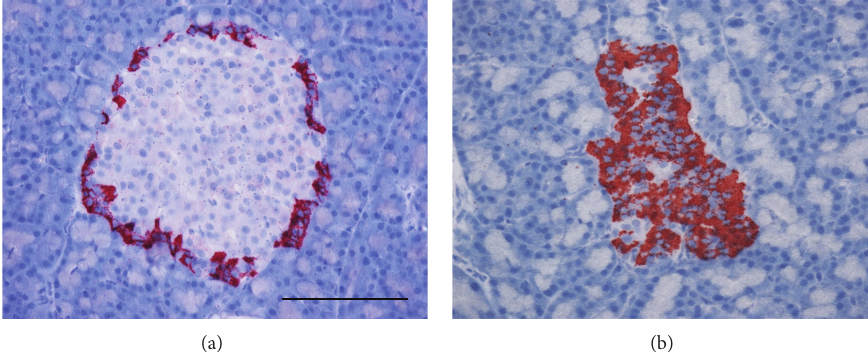
Figure 3: Lymphocyte infiltration in BBDR rat pancreas. Staining of 𝛼 -cells with anti-glucagon antibodies (red), counter-stained with hematoxylin, showed no immune cell infiltration in the control (a) or diabetic (b) rats. Scale bar = 50 𝜇 m.